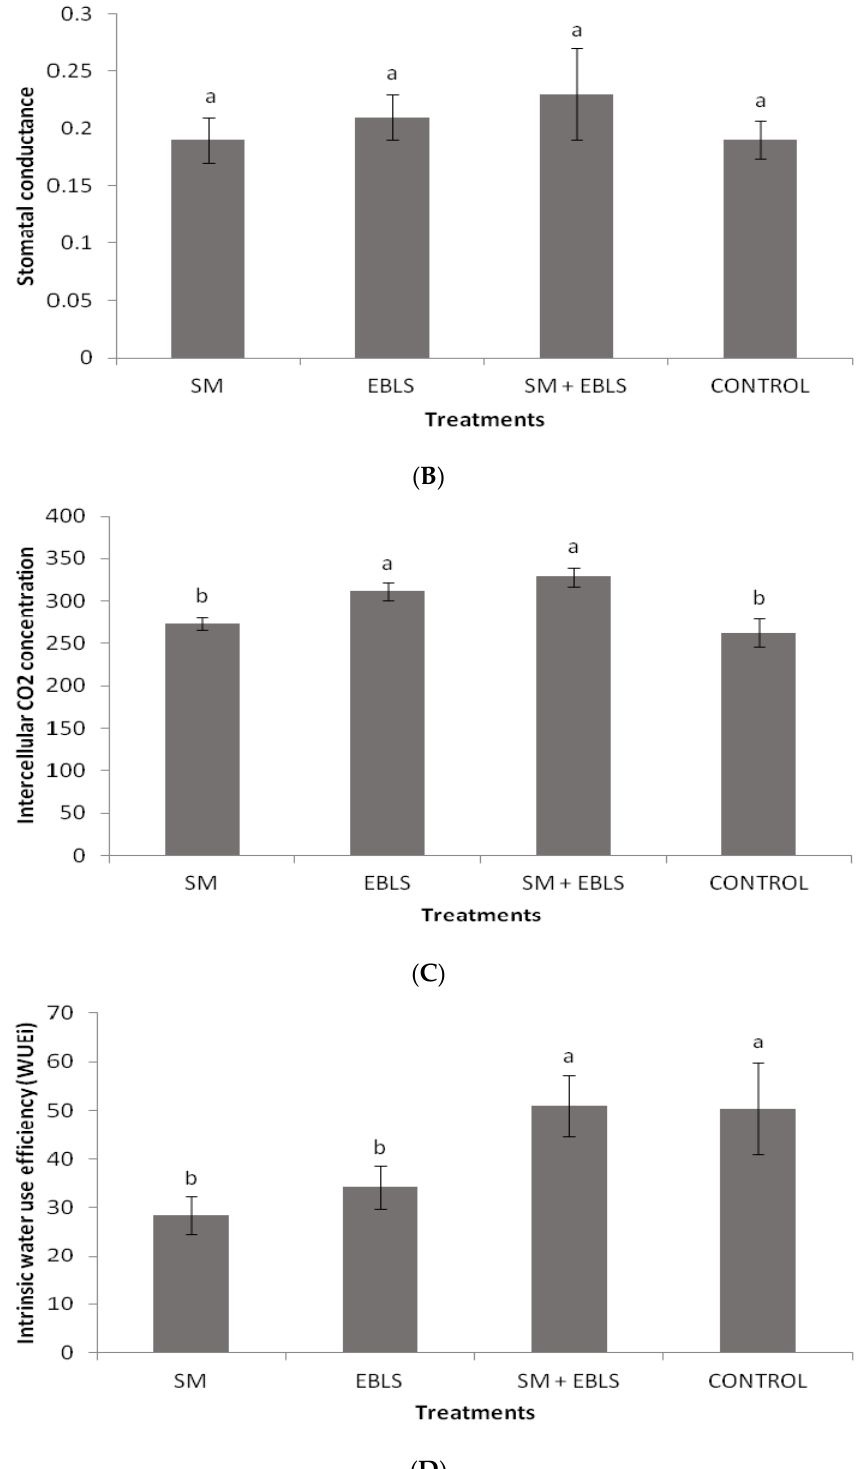
Figure 3. Photosynthetic rate ( μ mol CO 2 m − 2 sec − 1 ) ( A ), stomatal conductance (mol m − 2 sec − 1 ) ( B ), intercellular CO 2 concentration ( μ mol CO 2 mol air − 1 ) ( C ), and intrinsic water use efficiency ( μ mol CO 2 mol H 2 O − 1 ) ( D ) of the olive plants among the treatments at the end of the experiment. The different letters on the bars symbolize statistically significant differences among the treatments, according to Duncan’s multiple range test for p ≤ 0.05. SM = sheep manure; EBLS = organic material (litter) from evergreen broadleaf species, i.e., from Quercus sp.